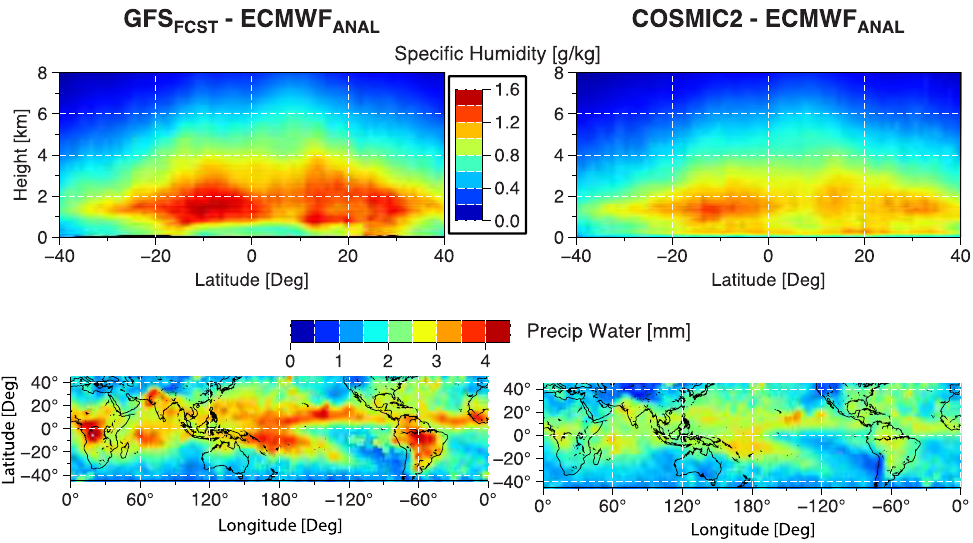
Figure 13. COSMIC-2 humidity retrievals (marked COSMIC2) versus short-term GFS forecasts (used as the background; marked GFS FCST ), with reference to ECMWF analysis (ECMWF ANAL ) for the period from 16 July 2019 to 1 February 2020. Left panels are standard deviations of GFS FCST - ECMWF ANAL and right panels are those of COSMIC2-ECMWF ANAL . Upper panels are for the specific humidity (g kg −1 ) and lower panels are for the precipitable water (mm).